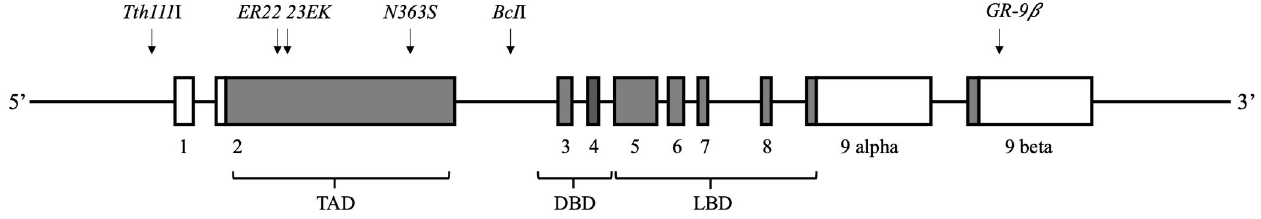
Fig 2. Schematic representation and localization of the NR3C1 gene polymorphisms Tth111 I, ER22 , 23EK , N363S , Bcl I and 9 β (rs10052957, rs6189, rs6190, rs56149945, rs41423247, rs6198). Tth111 I: in flanking area; ER22 , 23EK , N363S : exon 2 at TAD; Bcl I: intron between exons 2 and 3; 9 β : exon 9. TAD: transactivation domain; DBD: DNA binding domain; LBD: ligand binding domain.